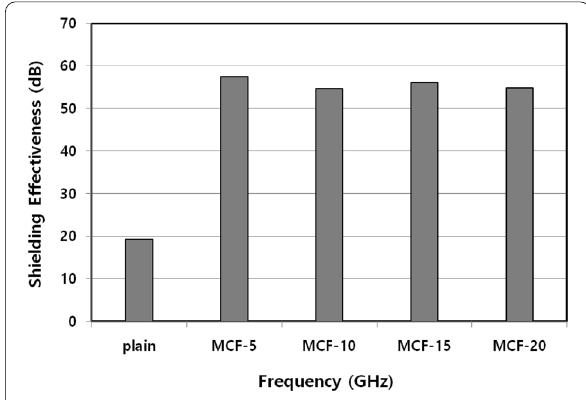
Fig. 9 EMP shielding performance according to MCF content. Fig. 10 Average EMP shielding